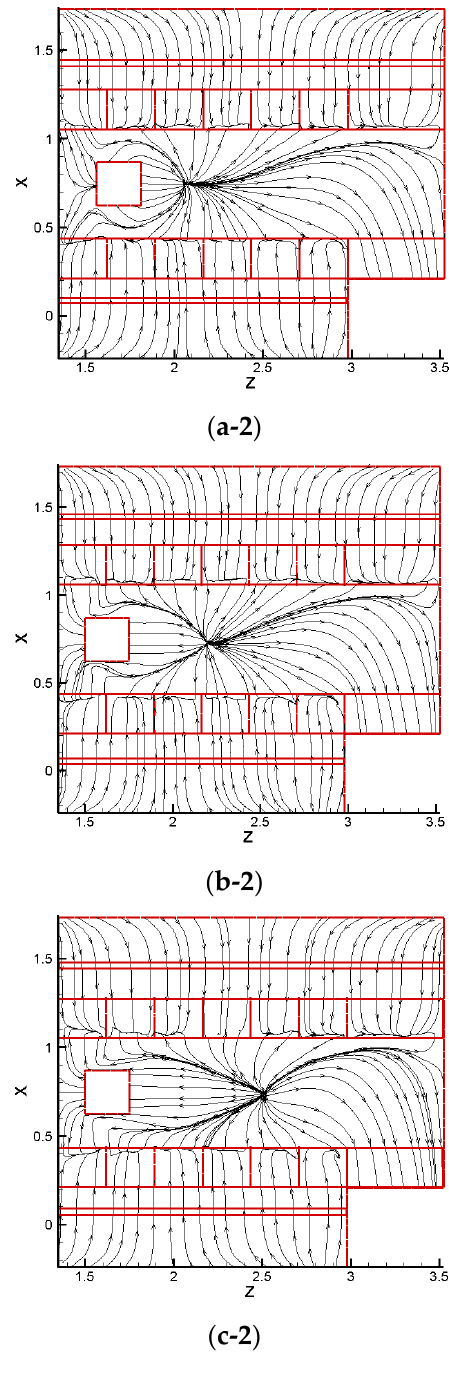
Figure 8. Evolution of the X-Z cross section airflow distributions (at Y = 0.77 m) while a crane moves along the Z axis with a velocity of ( a ) 0.3 m/s; ( b ) 0.4 m/s; and ( c ) 0.6 m/s at different locations. Here, 1 and 2 of sub-figures stand for the different location of the Z axis.